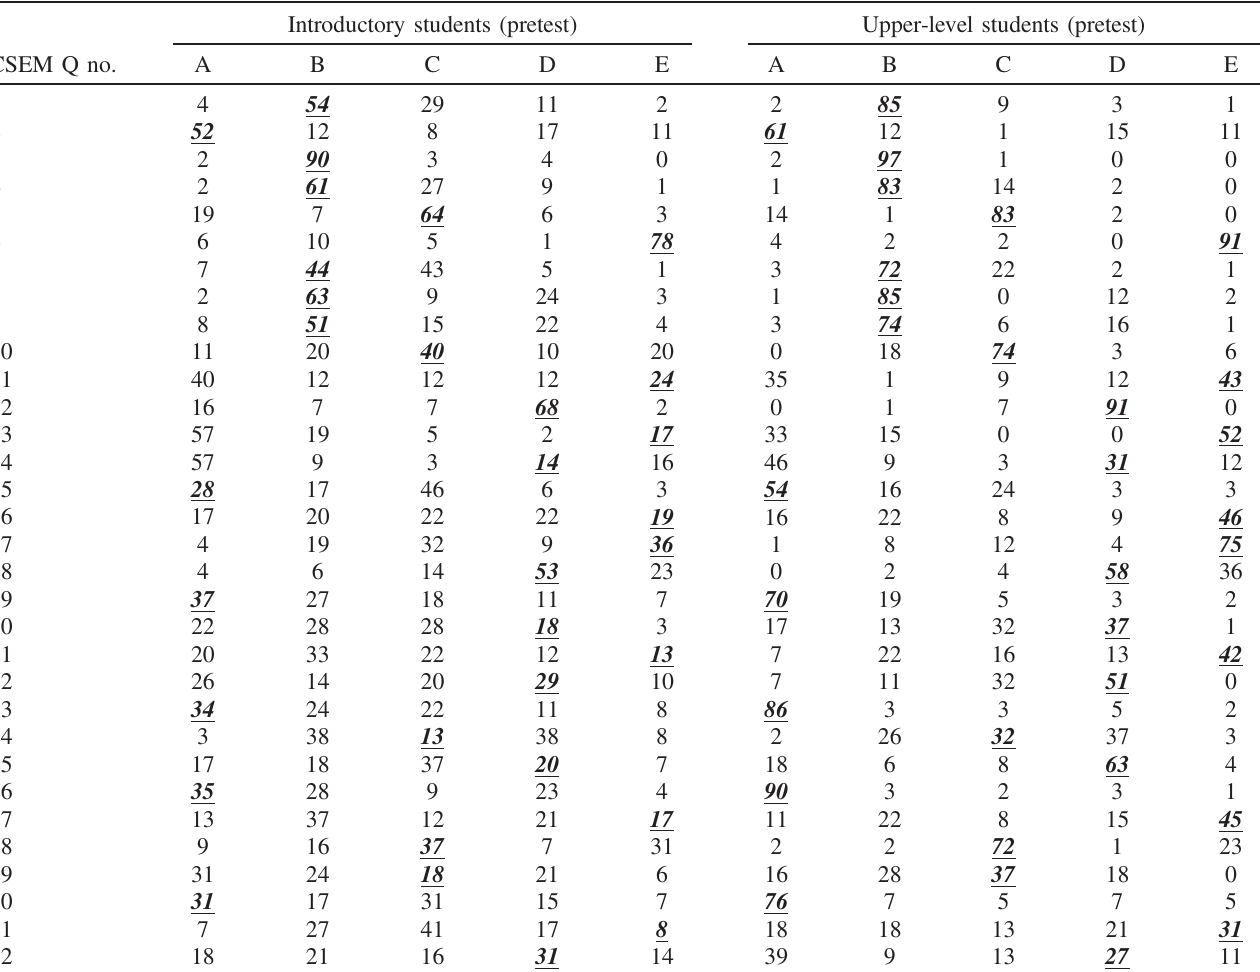
TABLE III. Percentages of introductory students and upper-level students who selected each answer choice on each question on the CSEM before instruction (pre-test). The bold and underlined numbers represent the correct answer for each question number. Introductory students (pretest) Upper-level students (pretest) CSEM Q